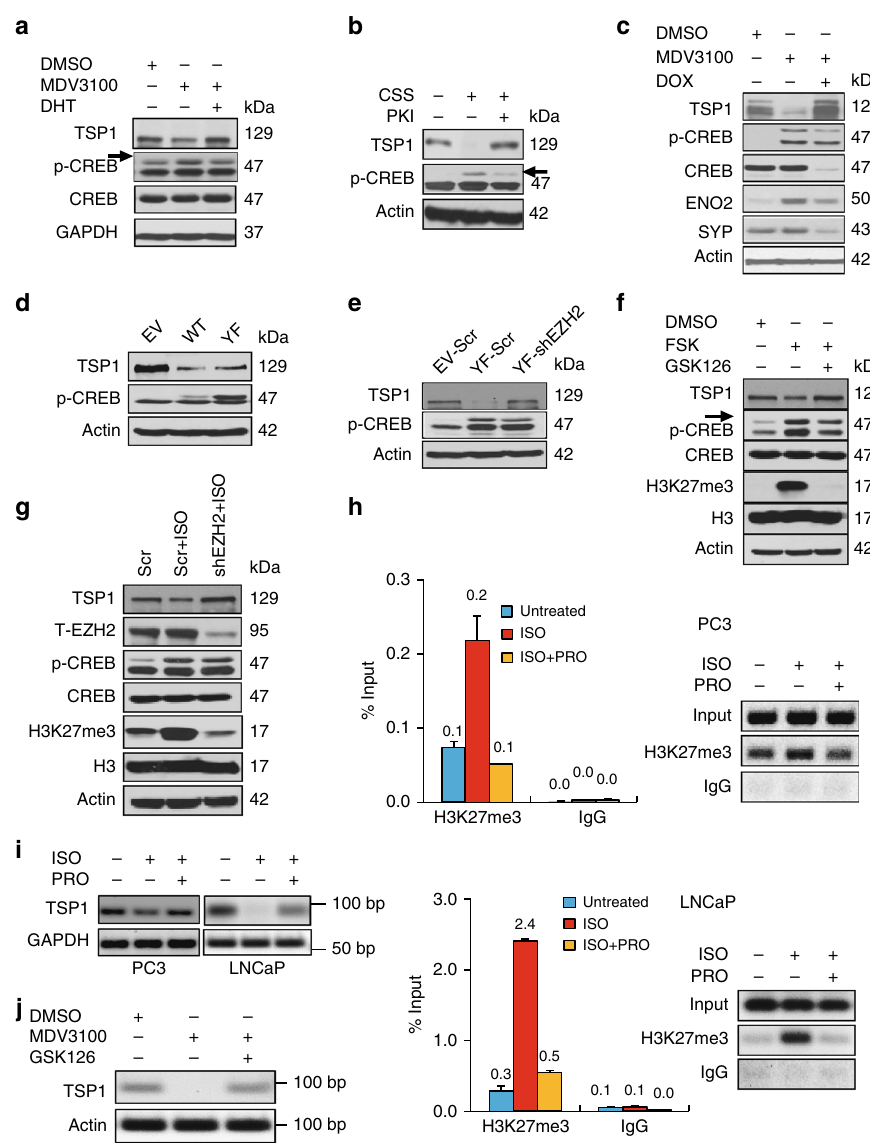
Fig. 8 ADT and CREB activation downregulate TSP1 through EZH2-mediated epigenetic repression. a Western blotting for TSP1 and p-CREB levels in 22Rv1 cells treated with 10 μ M MDV3100 for 72 h without or with 5 nM of DHT for 24 h. b LNCaP cells were grown in CSS medium for 48 h, without or with subsequent treatment of 10 μ M PKA inhibitor PKI for 5 h. TSP1 and p-CREB protein levels were assessed by western blotting. c Protein level changes of p-CREB, TSP1, and NE markers in LNCaP-Dox-ACREB cells treated by MDV3100 with and without Dox for 72 h. ACREB, a CREB inhibitory polypeptide, is induced by Dox. d TSP1 expression in PC3 cells overexpressing empty vector, wild-type (WT) or constitutively active mutant (Y134F) of CREB cDNA. e PC3 cells expressing empty vector or CREB-Y134F were infected with pLKO.1 lentivirus for shEZH2, followed by the examination of TSP1 expression. f PC3 cells were treated with 10 μ M PKA/CREB activator forskolin (FSK) with or without EZH2 inhibitor GSK126 (5 μ M) for 24 h. Levels of indicated proteins were measured by western blotting. g PC3 cells expressing shEZH2 were treated with 10 μ M PKA/CREB activator ISO for 24 h. PC3 cells expressing Scramble control shRNA were used as control. h LNCaP and PC3 cells were treated with 10 μ M PKA/CREB signaling activator ISO, with or without 10 μ M PKA/CREB signaling inhibitor PRO, for 24 h, followed by ChIP assay using anti-H3K27me3 or IgG control antibody. The amount of H3K27me3 histone marks on TSP1 promoter was measured by quantitative PCR and presented as % of the input ( Y -axis). DNA gel electrophoresis was performed to visualize the PCR results. i RT-PCR for TSP1mRNA changes in PC3 and LNCaP cells that were treated similarly as in the ChIP-qPCR above. j LNCaP cells were treated either with DMSO, 10 μ M MDV3100 without or with 5 μ M GSK126 for 72 h. RT-PCR was done for TSP1 and beta